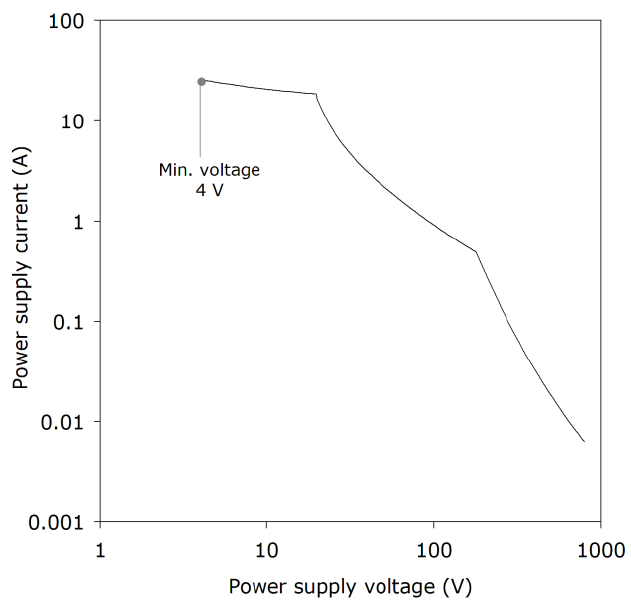
Figure 6. Ignition of 8.3% methane/air mixtures with a resistive circuit: relation between voltage and MIC (SMRE Intermittent Break-flash test apparatus) .